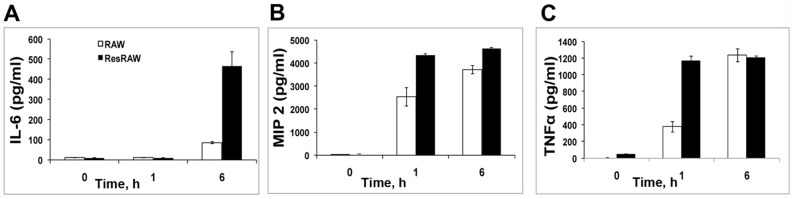
Cytokine production in response to PAO1.IL6 (A), MIP2 (B) and TNFα (C) secretion by naïve (solid line) and resistant (dotted line) RAW 264.7 cells were quantitated by ELISA, as described in Methods. Cells were exposed to PAO1 at MOI 10 for 1 h and recultured. Supernatants were collected at 0, 1 and 6 h. Cytokine production of mean +/− SD of three wells for each condition.